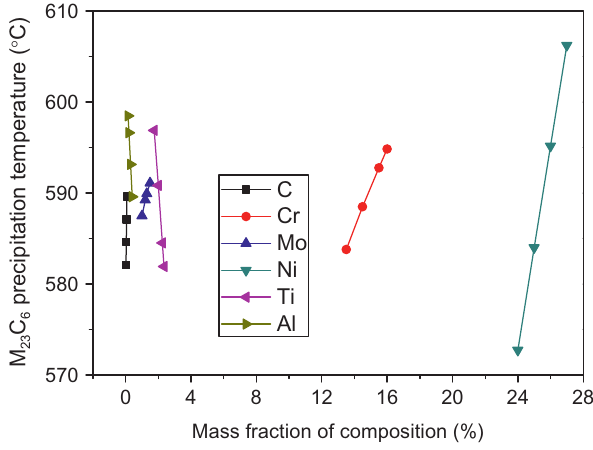
Figure 17: Influence of different elements on solution temperature of M 23 C 6